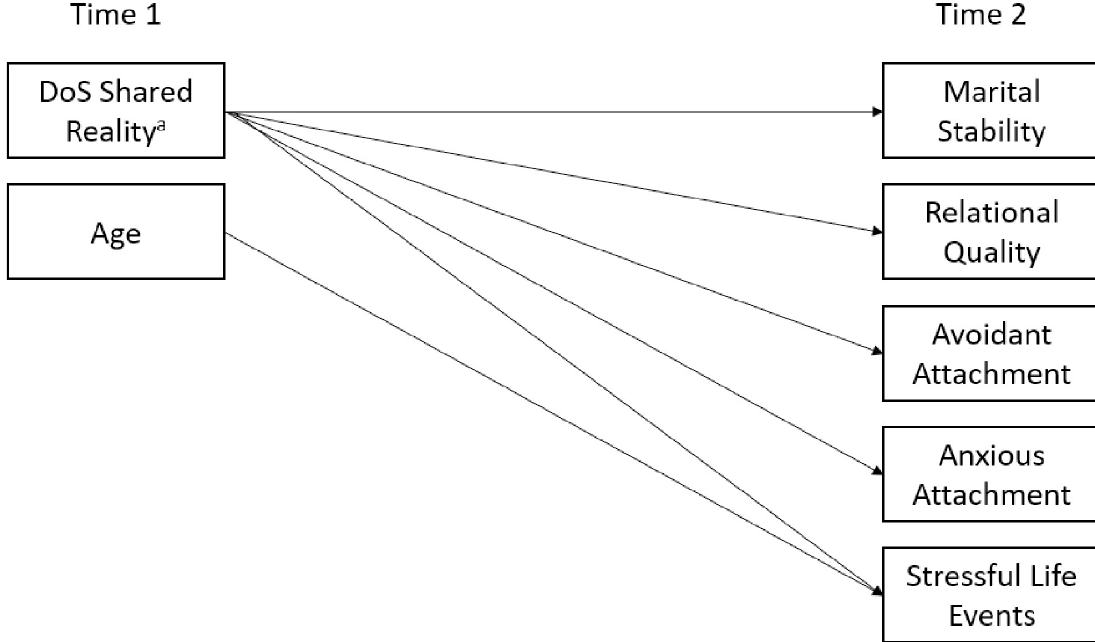
Fig 1. Conceptual path diagram. This figure represents the conceptual model used to analyze the association between a couple shared reality score of differentiation of self on a variety of outcomes. a DoS = differentiation of self. The shared reality score was computed by summing the scores of differentiation of self for each of the two individuals in each couple relationship. b Please note that the actual model included paths from DoS shared reality to scores on the five outcomes for men and women within one model. Additionally, a multigroup analysis was run therefore paths for U.S. and Spanish participants were estimated separately in two